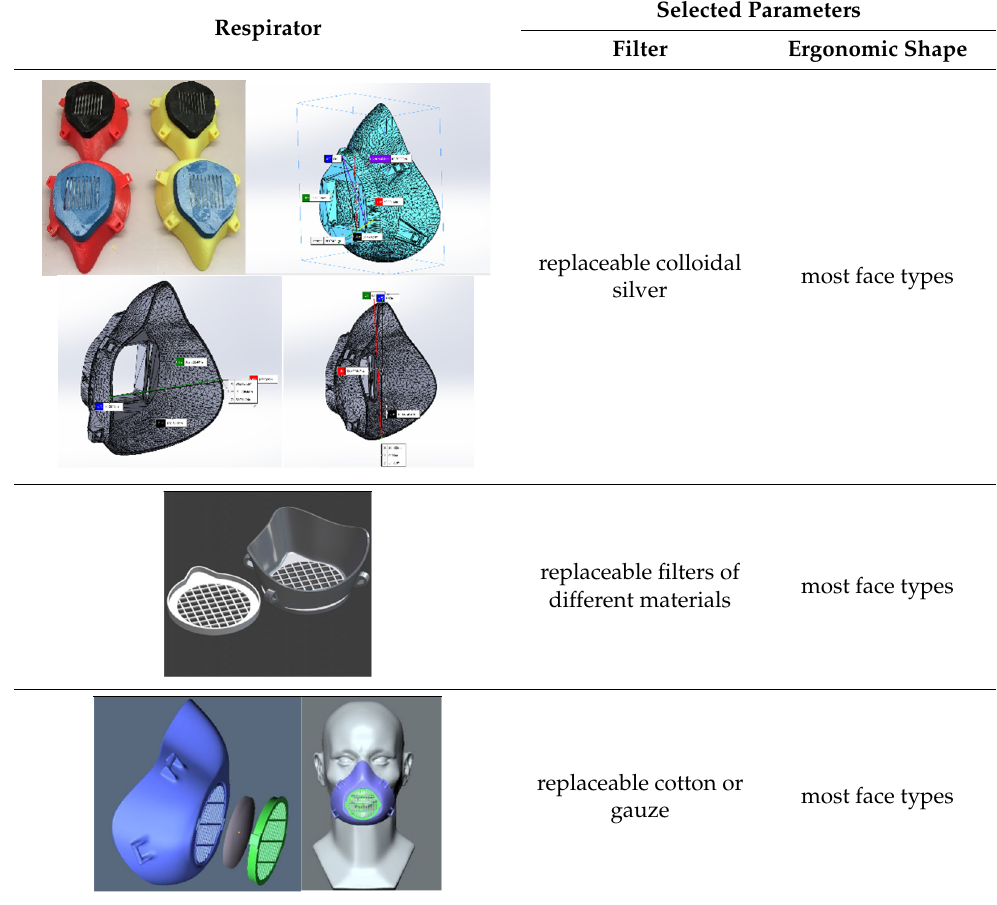
Table 3. Selected parameters for respirator comparison.